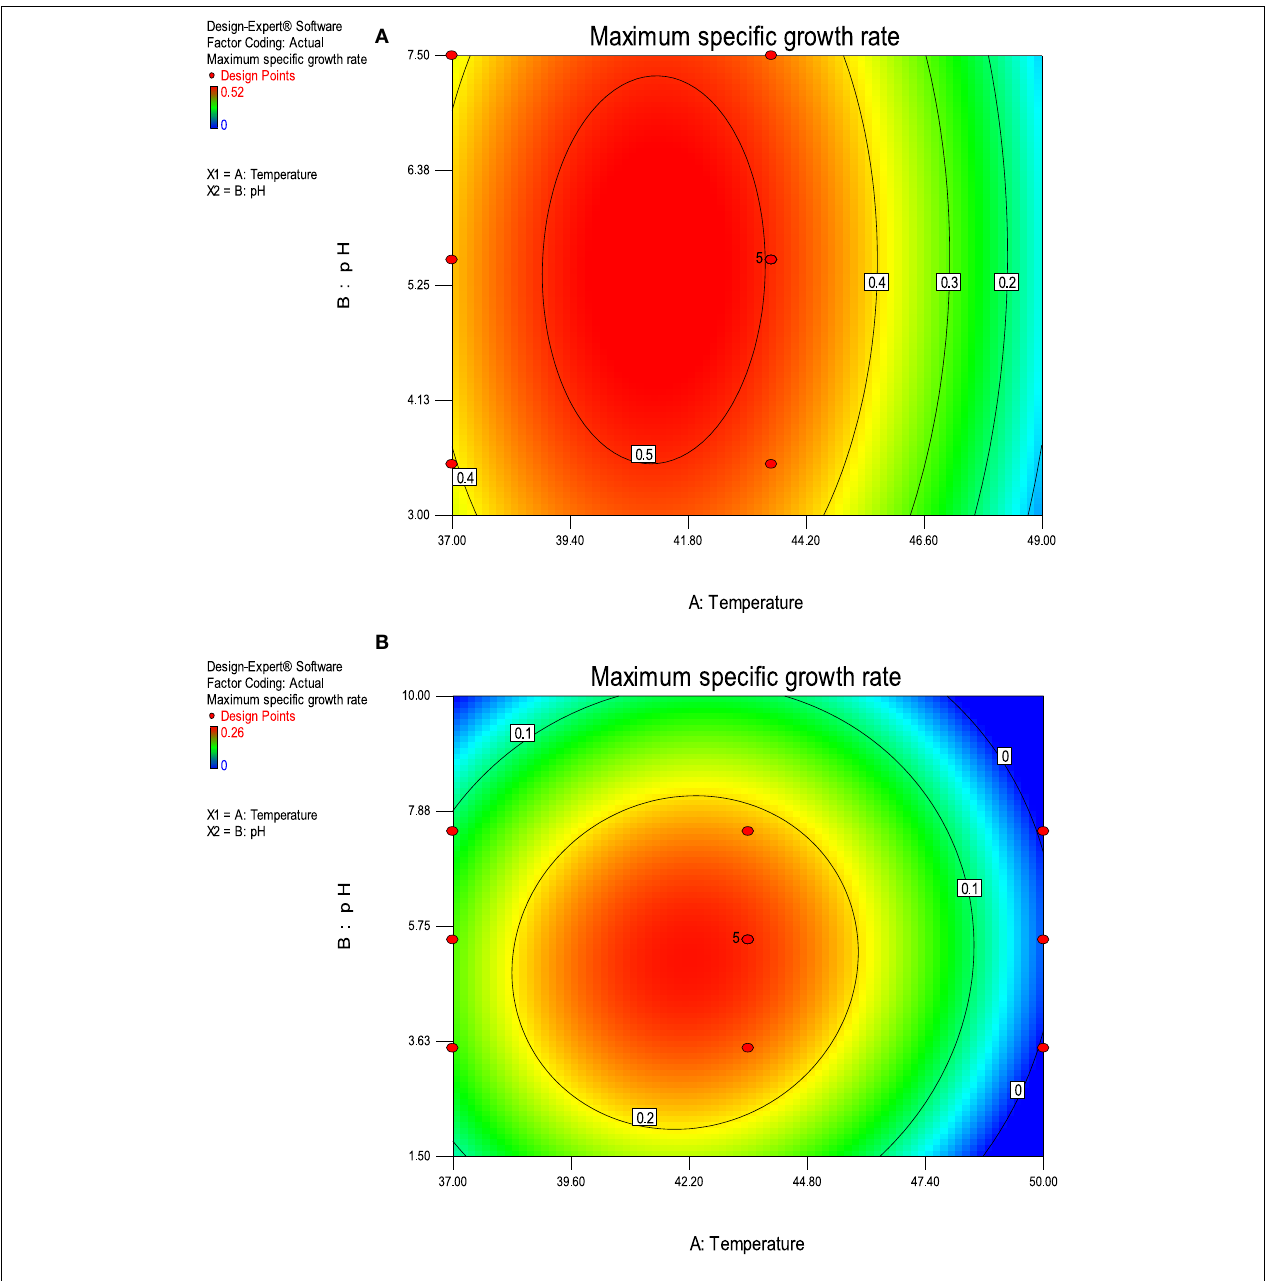
FIGURE 7 | Contour plot of maximum specific growth rate as a function of temperature and pH (A) K. marxianus NIRE-K1 (B) K. marxianus NIRE-K3.